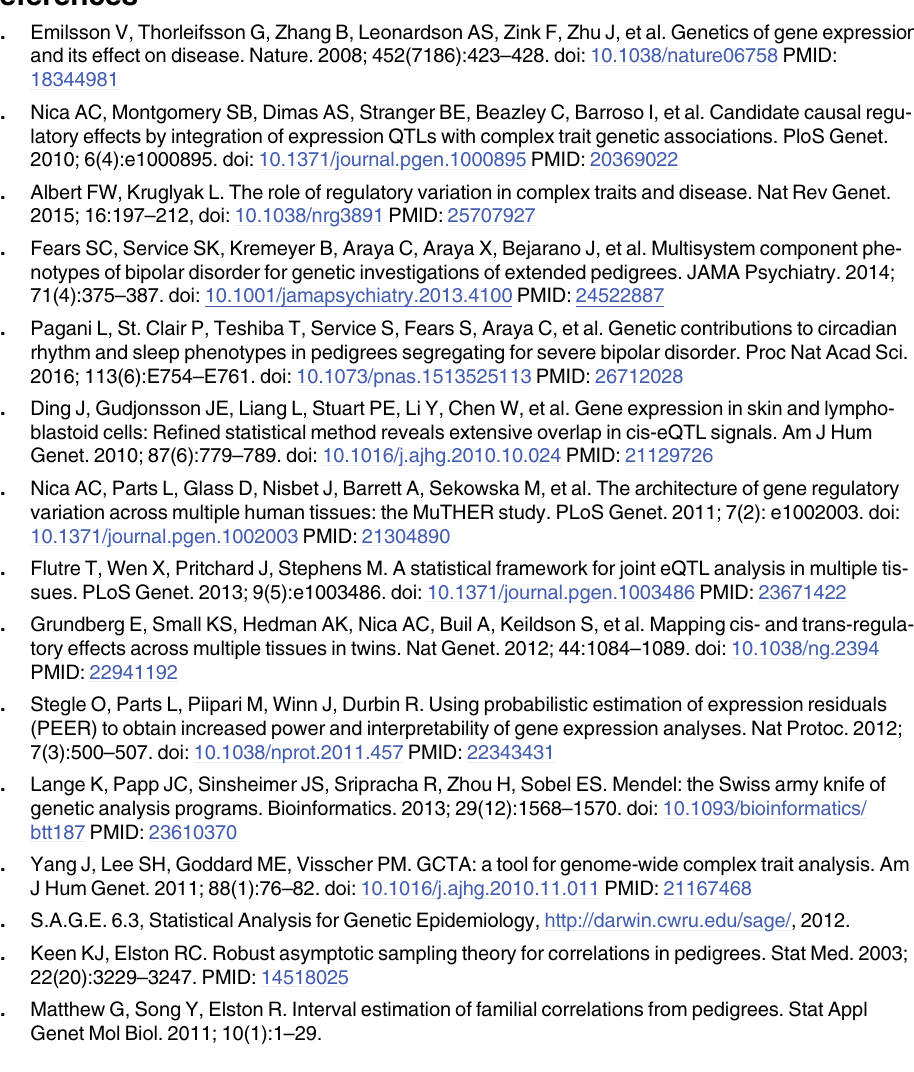
S3 Table. Distal eSNPs found in previous studies. SNPs with distal association to one or more genes in our work (FDR 5%) and with distal association in published studies to any gene (p < 5e-08). The SNP positions are based on hg 19. "# genes" denotes the number of genes in the current study, while "# genes comp" denotes the number of genes discovered in the compar- ison